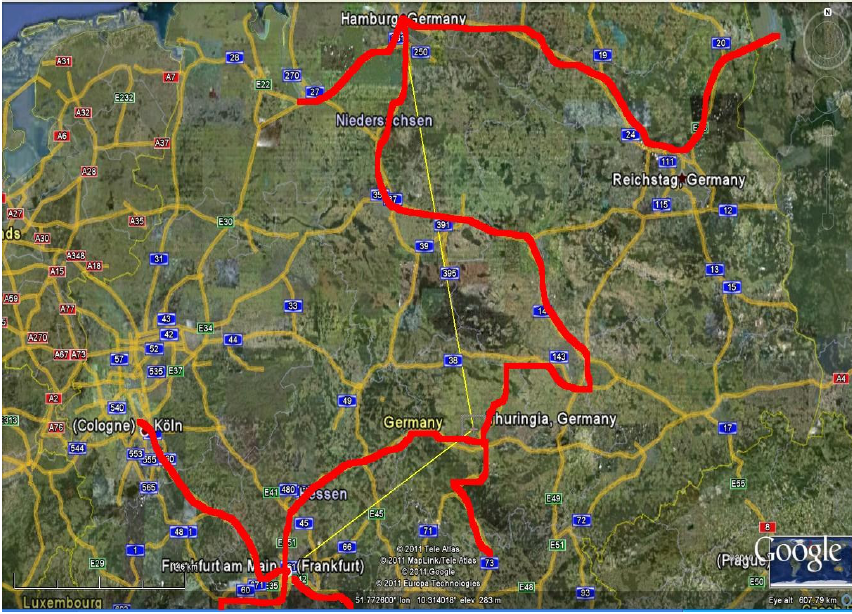
Figure 17. The real roads, in red, connecting the German towns involved into the epidemics.